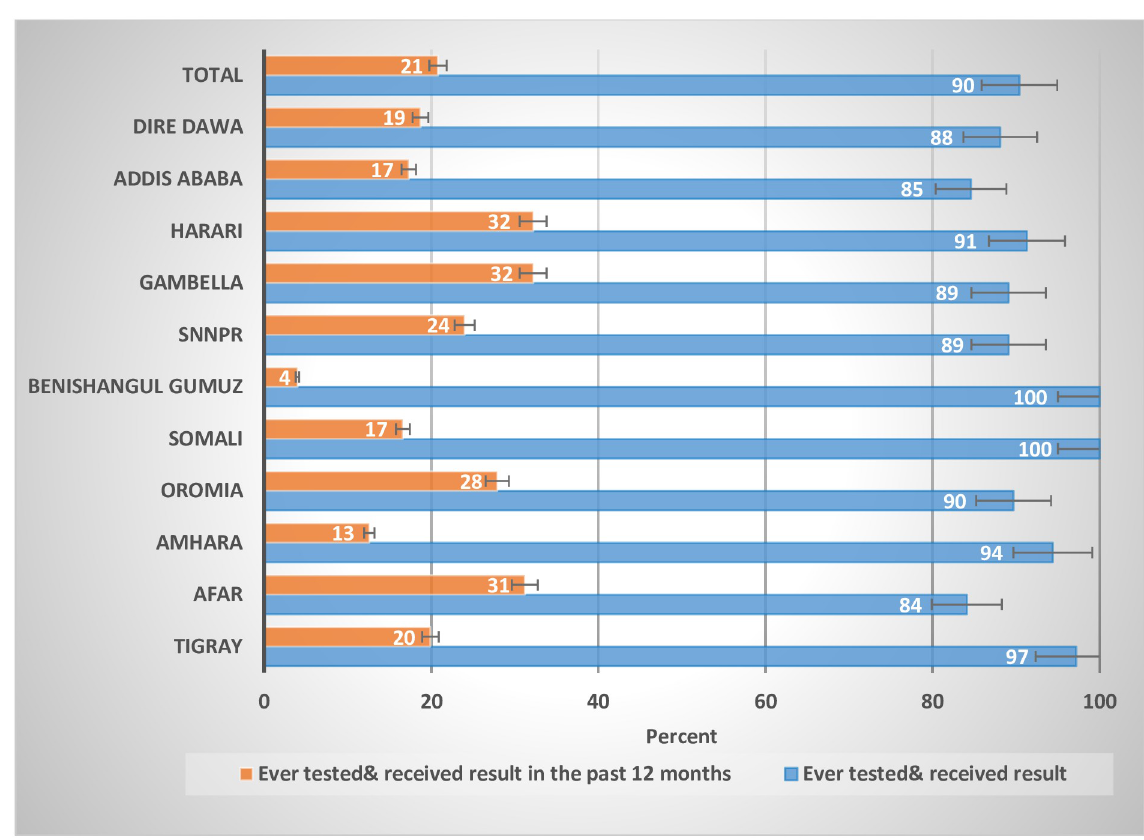
Fig 1. Distribution of self-reported HIV testing coverage by region among HIV-positive participants aged 15–64 years, 2017–18.